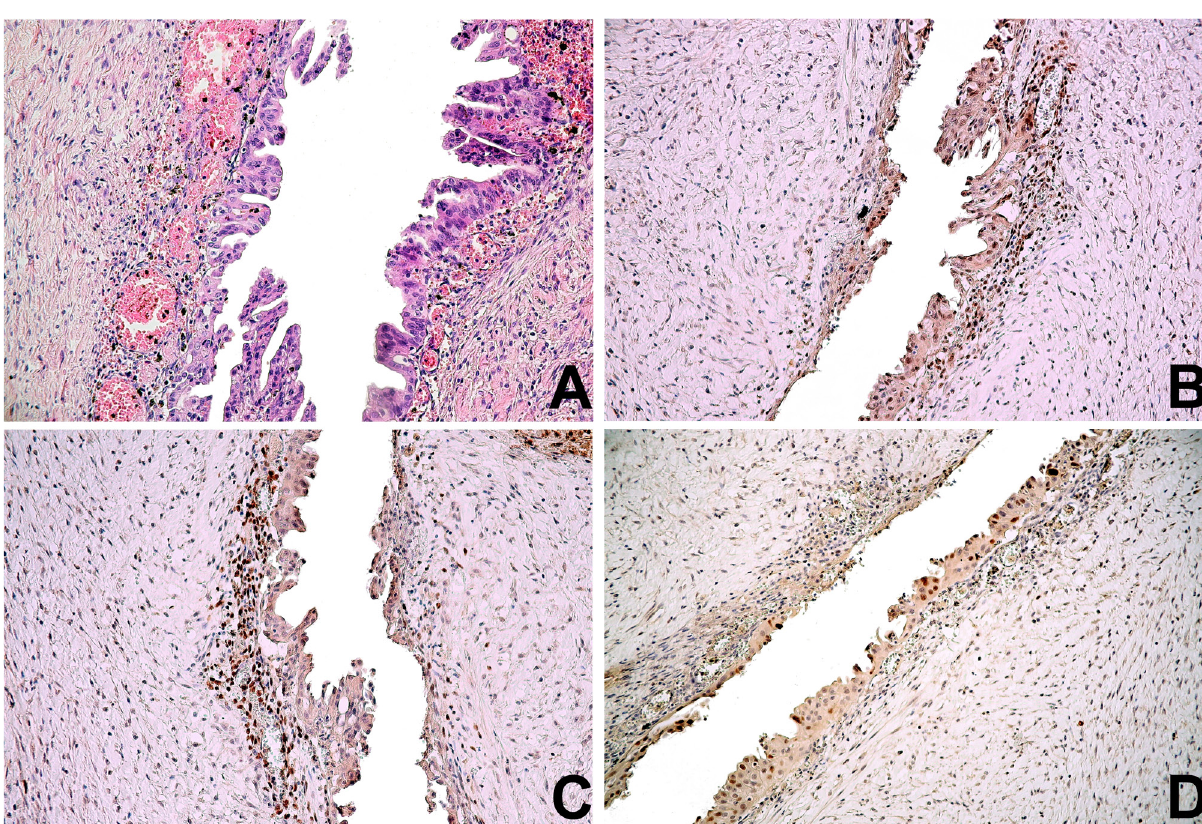
Fig. 1. Atypical ovarian endometriosis and immunohistochemical expression of ER, PR and p53 in atypical ovarian endometriosis. A: Atypical ovarian endometriosis consisting of cells with eosinophilic cytoplasm, large hyperchromatic or pale nuclei with mod- erate to marked pleomorphism, an increased nuclear to cytoplasmic ratio, cellular crowding, stratification and tufting. Note the absence of the acute inflammatory infiltrate (hematoxylin-eosin staining, original magnification ×200). B: Nuclear expression of ER in approximately 40% of endometrial glandular cells with only moderately staining (immunohisto- chemistry, original magnification ×200). C: Nuclear expression of PR in less than 1% of endometrial glandular cells (immunohistochemistry, original magnification ×200). D: Strong nuclear expression of p53 in approximately 28% of endometrial glandular cells (immunohistochemistry, original mag- nification